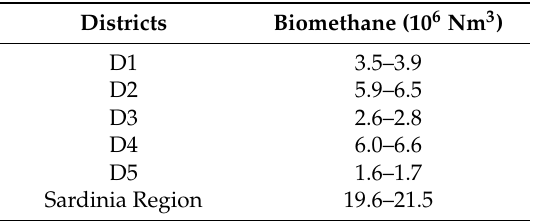
Table 5. Biomethane potential ranges per each district, year